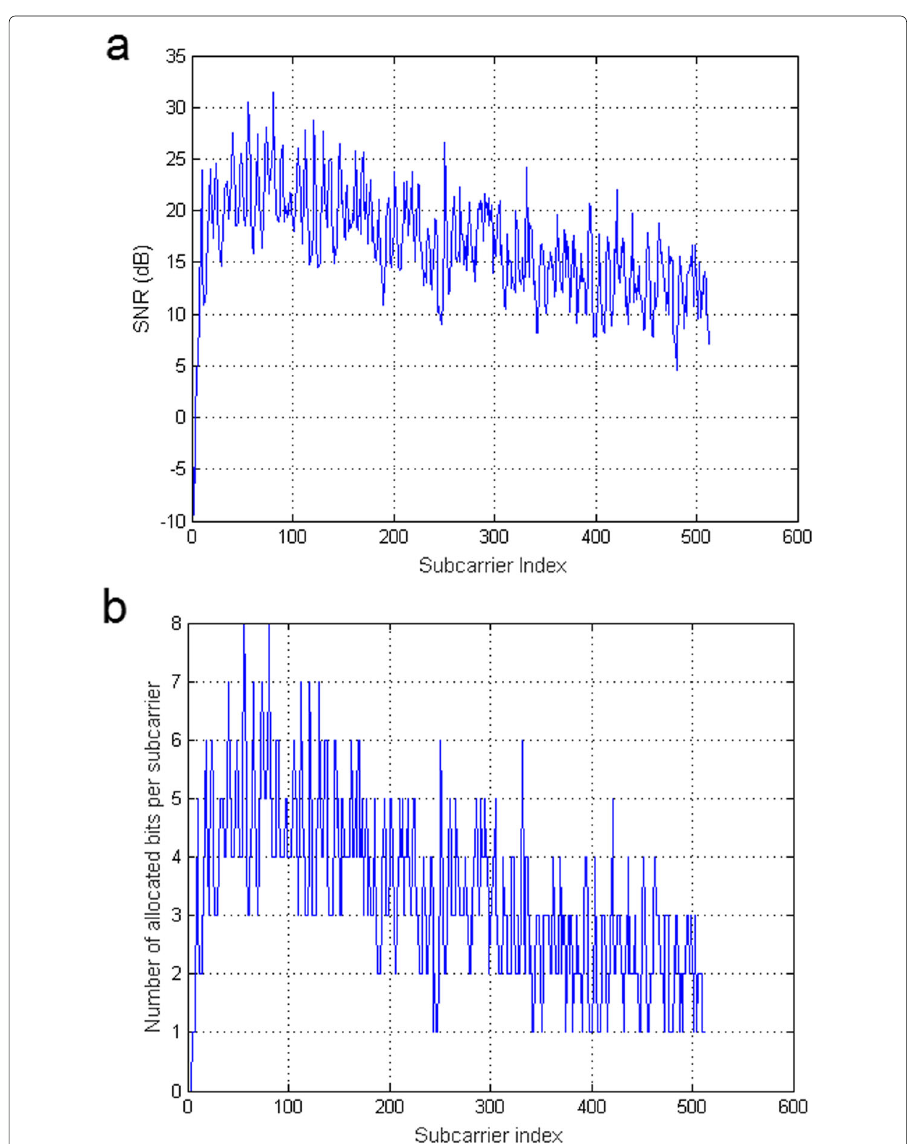
Fig. 16 SNR ( a ) and allocated bits ( b ) per subcarrier. Estimation per subcarrier at 500 lux